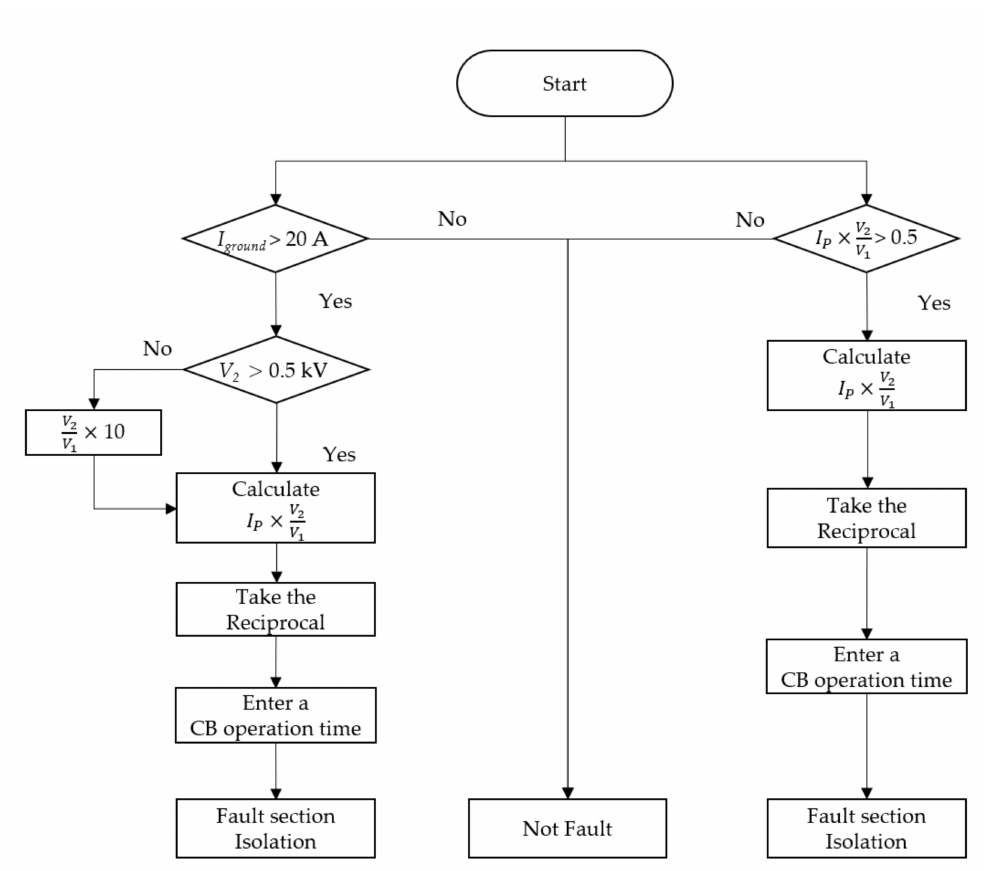
Figure 9. Block diagram of